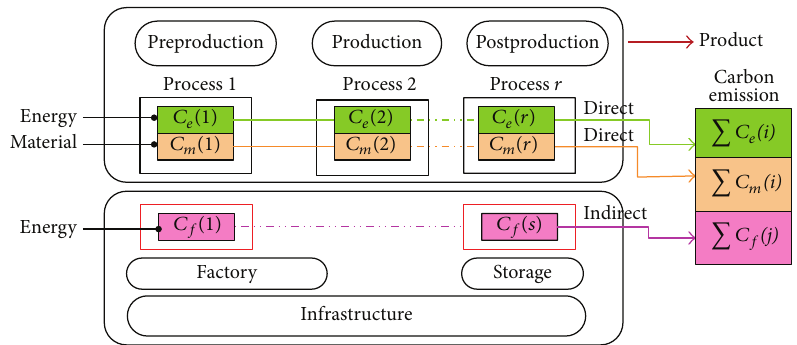
Figure 2: Carbon emission analysis framework for a product